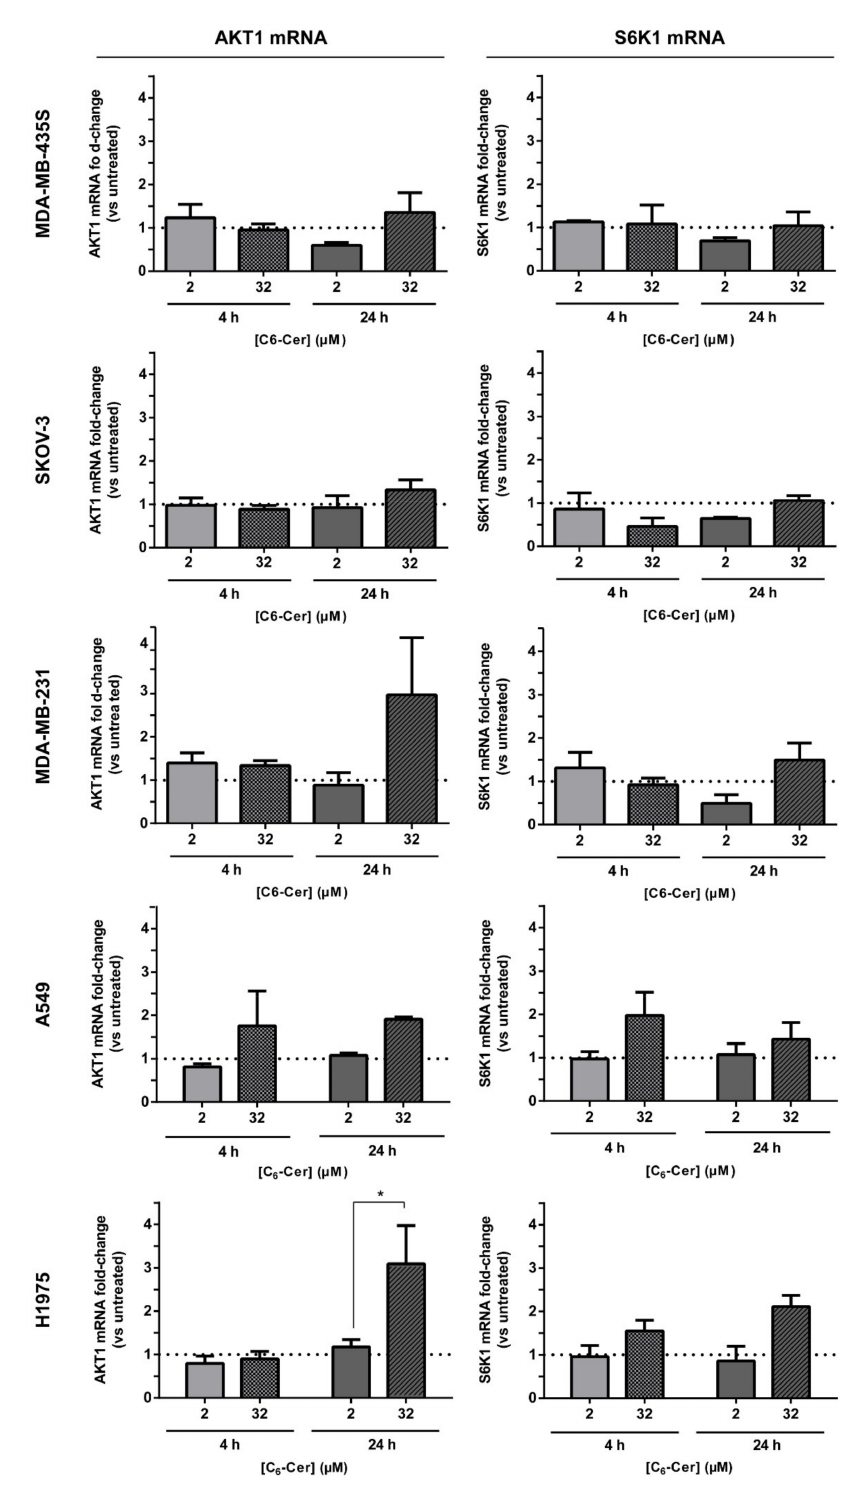
Figure 7. Impact of F3 peptide-targeted liposomal C6-ceramide in the mRNA levels of PI3K/Akt pathway-associated effectors in cell lines of diverse histological origin. Representation of the relative mRNA fold-change of AKT1 and S6K1 in MDA-MB-435S, SKOV-3, MDA-MB-231, A549 and H1975 cells, following incubation with the indicated concentration of C6-ceramide encapsulated in F3 peptide-targeted liposomes ([F3]L-C 6 ) for 4 and 24 h, at 37 ◦ C, relative to untreated control. Data represent the mean ± SEM ( n = 3; p -value was calculated using t -test, * p <